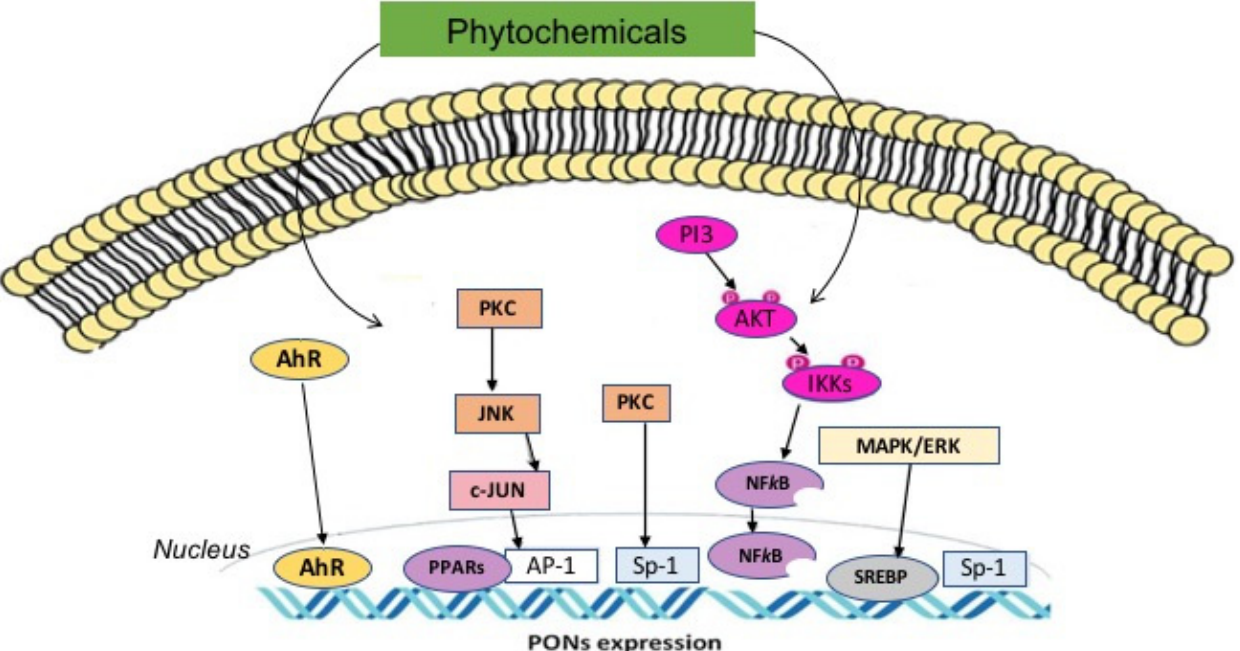
Figure 2. Effect of phytochemicals on signalling pathways that modulate PONs expression. AhR: aryl hydrocarbon receptor; PKC: Protein kinase C; JNK: c-Jun N-terminal kinase; PPARs: Peroxisome proliferator-activated receptors; AP-1: Activator protein 1; Sp-1Specificity protein-1; PI3K: Phosphoinositide 3-kinase; Akt: Protein kinase B; IKK: IK kinases; NF- κ B: Nuclear factor- κ B; MAPK/ERKs: mitogen-activated protein kinases/extracellular signal-regulated kinases; SREBPs: Sterol regulatory element-binding proteins.